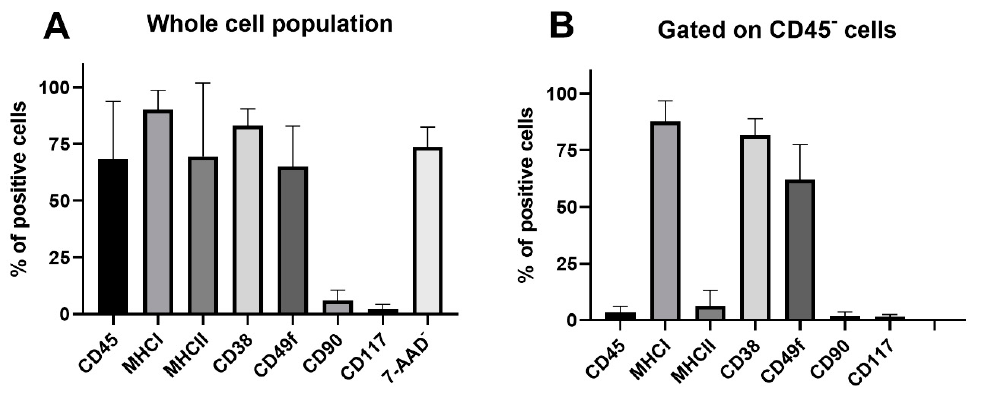
Figure 5. Phenotype of MACS-depleted and cultured cells analyzed by flow cytometry. Cultured cells highly expressed almost all analyzed markers except CD90 and CD117, while maintaining the cell viability about 70% ( A ). Phenotype of CD45 − gated cells was MHCI + MHCII − CD38 + CD49f + CD90 − CD117 − ( B ). The data from six experiments are expressed as the mean ± SD.